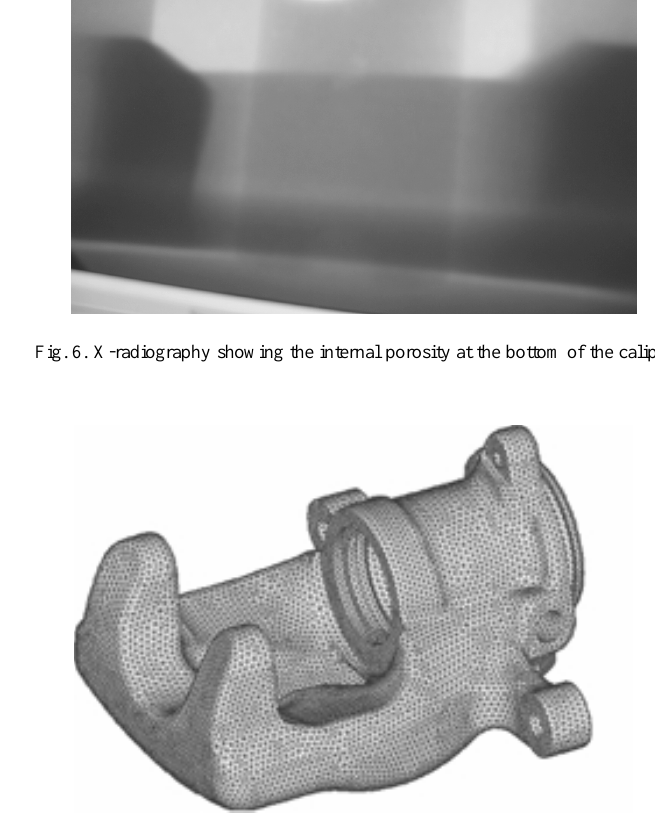
Fig. 7. Mesh of FE model of the